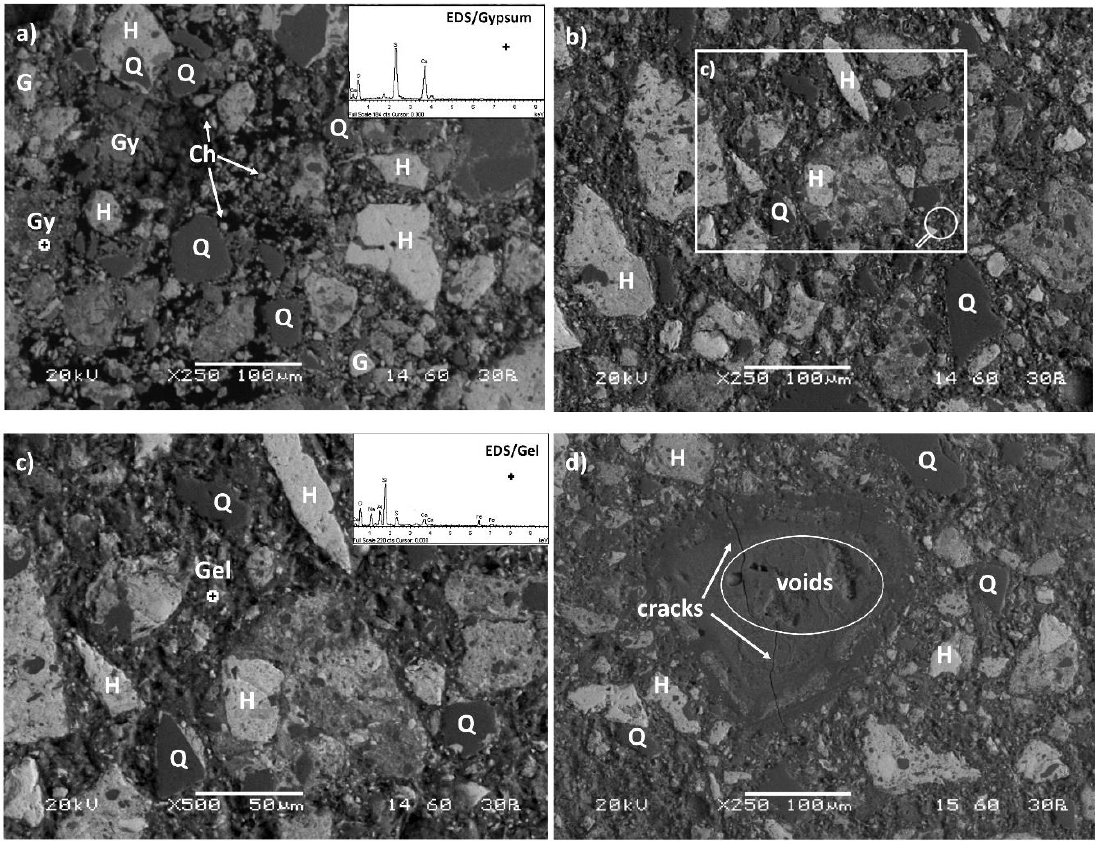
Figure 9. SEM-back-scattered electron (SEM-BSE) images of selected AAMs produced using ( a ) only laterite leaching residues (LR2 AAM) as well as by mixing ( b , c ) leaching residues and metakaolin at mass ratio 90:10 (LR90MK10) and ( d ) LR90MK10 fired at 800 ◦ C. Energy dispersive X–ray spectroscopy (EDS) spectra show in several spot locations the presence of crystalline phases, the formation of mixed aggregates, and newly formed products (Q: Quartz, H: Hematite,